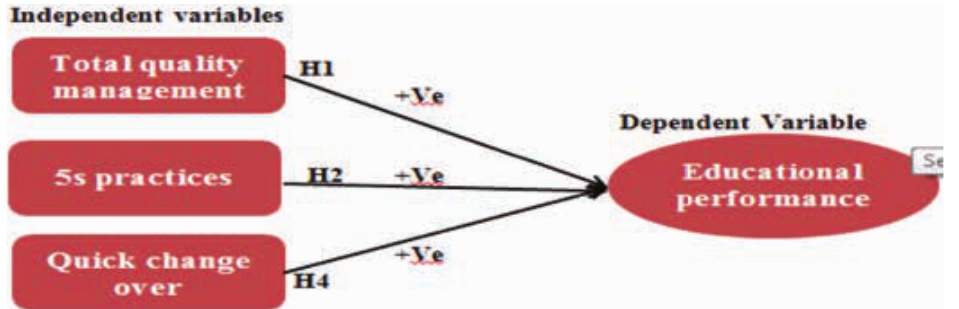
Figure 1: Research